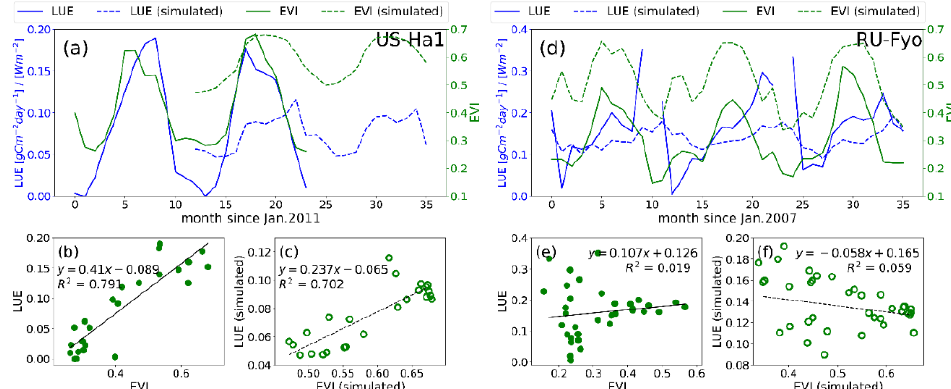
Figure 4. Time series (a, d) and scatter plots (b, c, e, f) showing contrasting relationships between monthly LUE and EVI at seasonal scale for US-Ha1 site (a-c, 2011-2013, deciduous broadleaf forest) and RU-Fyo site (d-f, 2007-2009, evergreen needleleaf forest). Results based on both real and simulated data are shown. Seasonal constant Vcmax values (57.7 and 62.5 for US-Ha1 and RU-Fyo, respectively) are used in SCOPE simulations.